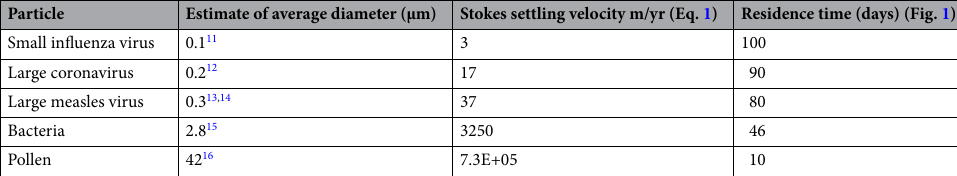
Table 1. Estimated aerosol settling velocities and residence times.